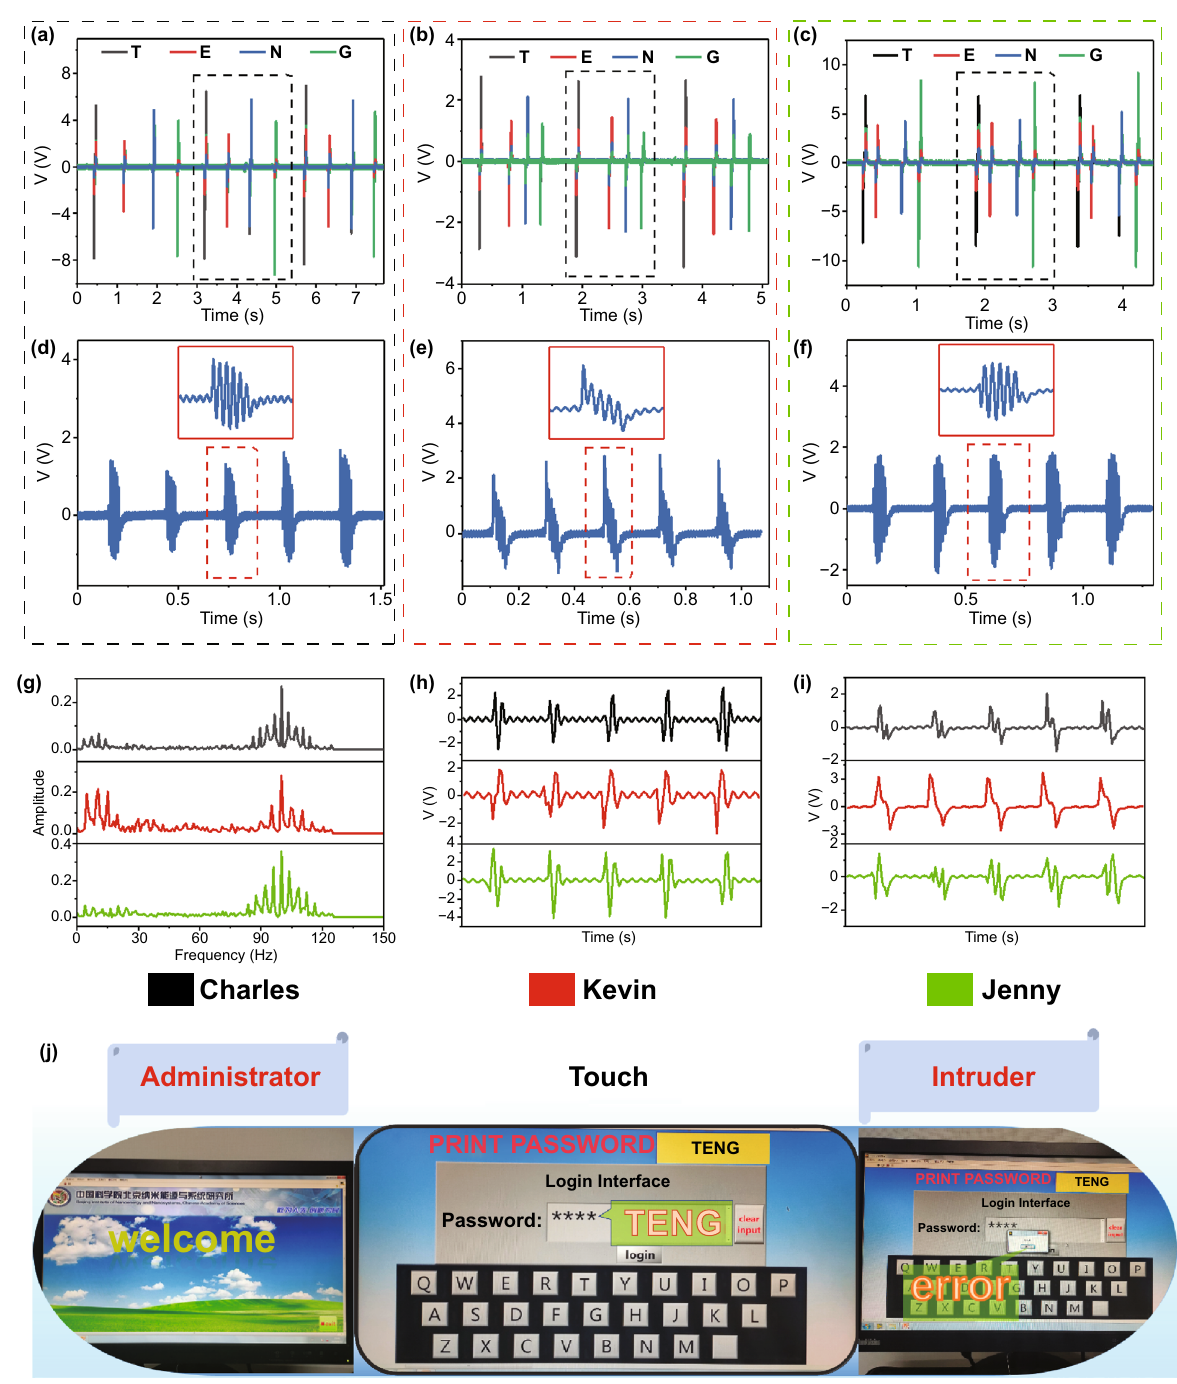
Fig. 6 Application of the self-powered wearable keyboard as a biometric authentication. a – c Repeated voltage signals generated from typing the F-TENGs by the three volunteers. d – f Difference in voltage signal generated by different experimenters pressing the same button a, d Charles, b, e Kevin, and c, f Jenny. g Spectrogram through the Fourier transform from the signal of different objects. h , i Detailed waveform after the wave- let transform, ψ 3 h and ψ 4 i . j SPWK with self-security function used to identify administrators and